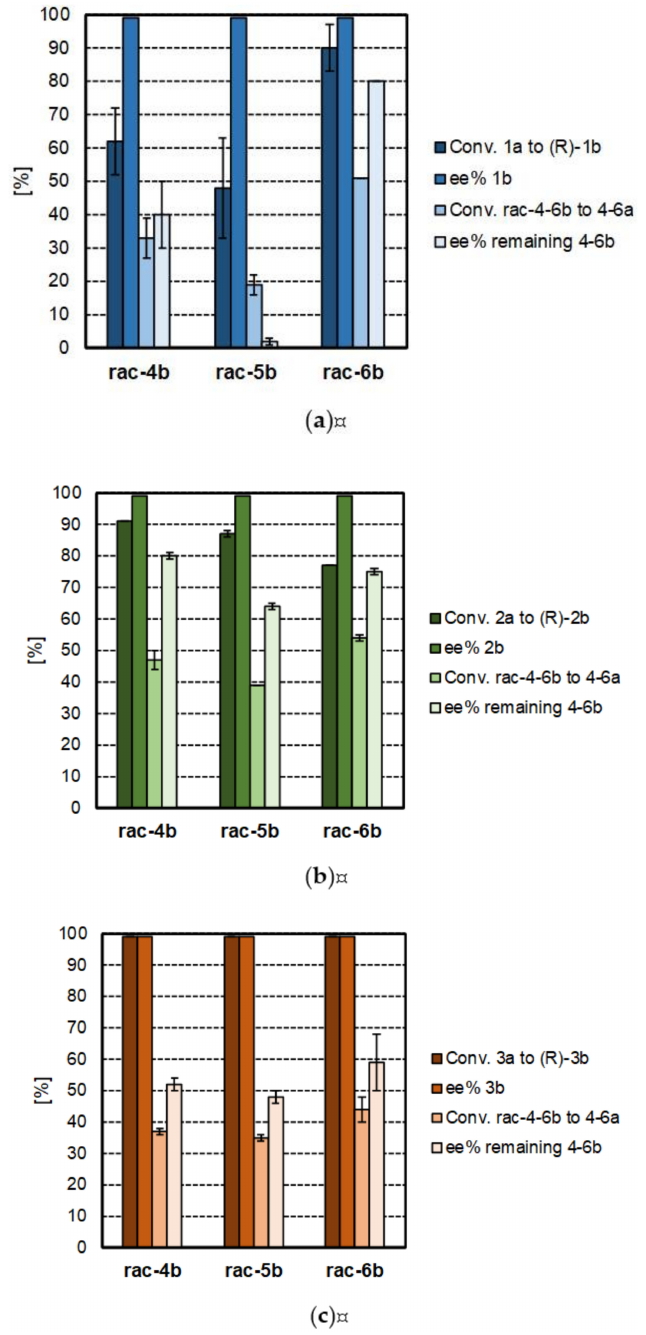
Figure 1. Screening of prochiral ketone substrates and racemic amine donors for the PIKAT. The y-axis represents either the percentage of conversion to product or the ee of the amines for the anti-parallel asymmetric formal reductive amination and kinetic resolution steps. Prochiral ketone substrates in the PIKAT reaction: ( a ) 1a , ( b ) 2a , and ( c ) 3a ; these ketones were tested with racemic amine donors 4 – 6b . Reaction conditions: toluene (a w = 0.7, reaction volume: 1 mL), 1 – 3a (50 mM), rac - 4 – 6b (100 mM), immobilized EziG 3 -AsR- ω TA (total mass of enzyme plus carrier material: ca. 22 mg; enzyme loading on carrier material: 10% w w − 1 ), hydrate salt pair (40 mg; ratio Na 2 HPO 3 • 5H 2 O / Na 2 HPO 4 • 7H 2 O, 1:1, w w − 1 ) in a dark 2 mL glass vial; agitation in a thermomixer at 900 rpm, 25 ◦ C, for 72